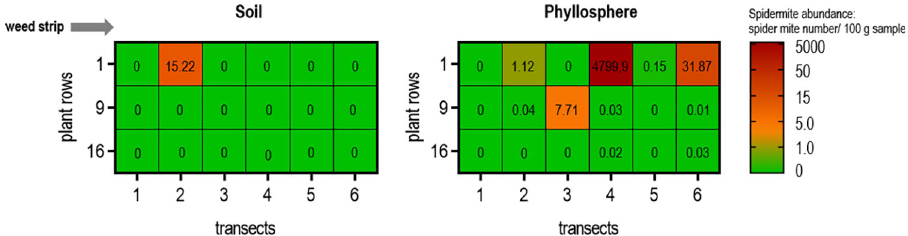
Fig 5. Spider mite abundance in the phyllosphere and soil of an open field cucumber cultivation. Plot dimensions were 500 m long and 30 m wide included 19 plants rows and 6 transects. Three to five leaves and two soil samples were collected at one sampling point and merged together for analysis. Quantification of spider mites in the samples was conducted by HRM real-time PCR (spider mite number/ 100 g sample). The spider mite number/ 100 g sample increases from green to red. Spider mite colonization of the crop is highest at the field edge adjacent to the weed strip. The spider mite colonization of soil and phyllosphere do not influence each